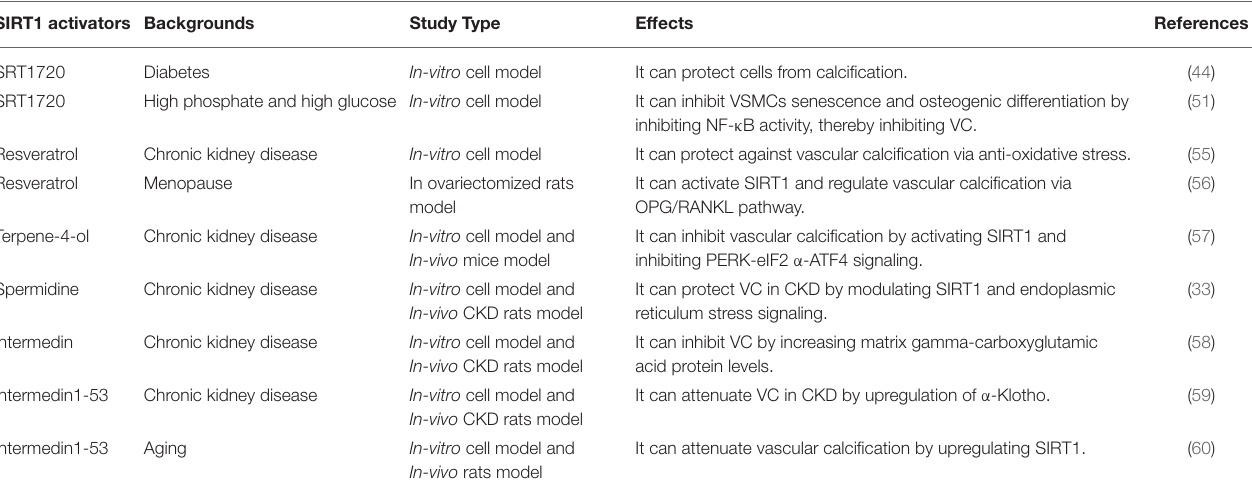
TABLE 1 | The applications of SIRT1 activators in vascular calcification. SIRT1 activators